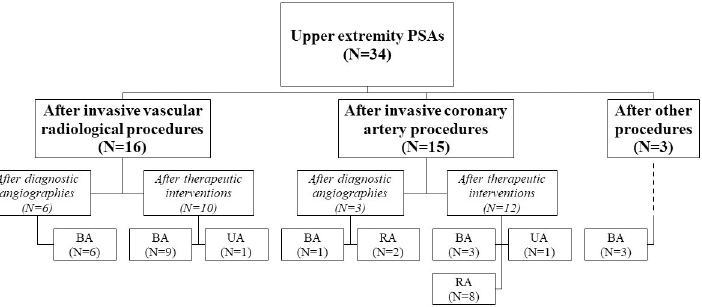
Fig 1. Upper extremity pseudoaneurysms. BA , Brachial artery; PSA , pseudoaneurysm; RA , radial artery; UA , ulnar